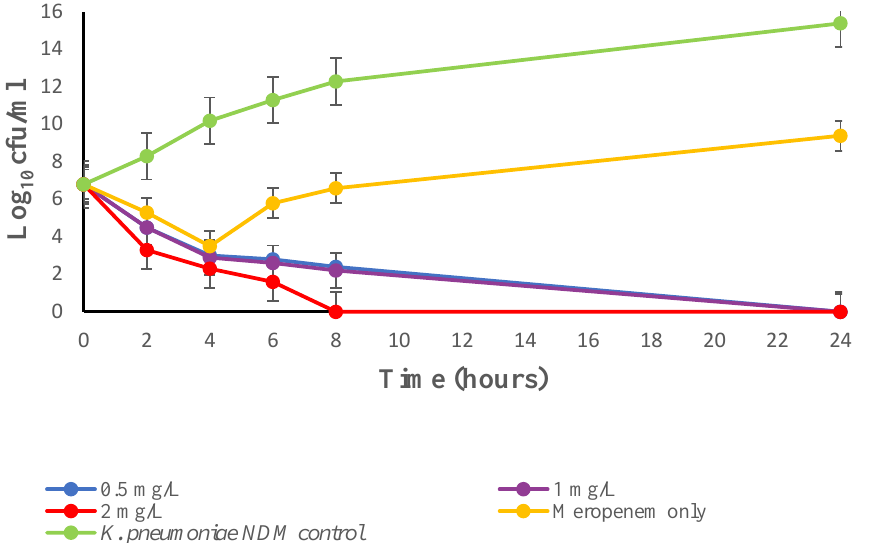
Figure 3. Time-kill kinetic study of K. pneumoniae NDM using BP2 MBLI + meropenem. K. pneumoniae NDM was challenged with either 2 mg/L (red circles), 1 mg/L (purple circles) or 0.5 mg/L (blue circles) of meropenem + a fixed BP2 concentration of 32 mg/L to ascertain the level of efficacy achieved by combination therapy utilizing differing meropenem concentrations. Combination therapy was compared against monotherapy (meropenem only, yellow circles) and no therapy (green circles, bacterial control).